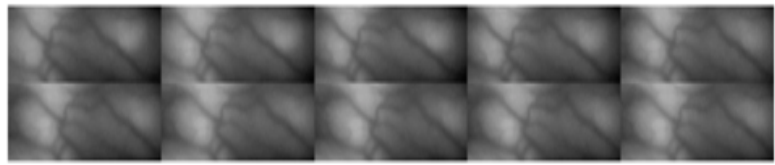
Figure 10. Example of captured images of one person in the Finger Vein database [61].